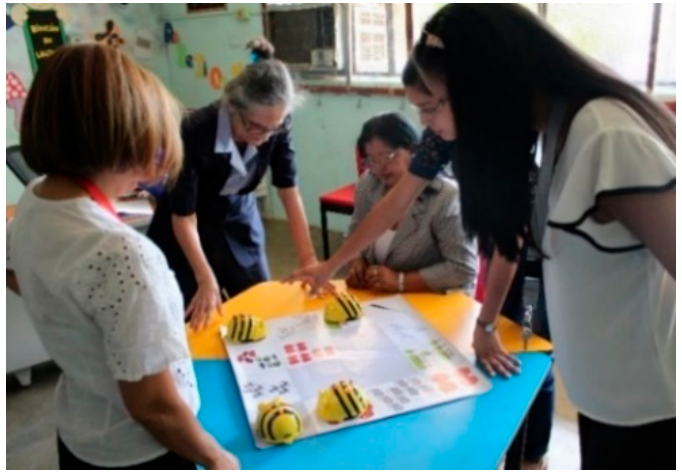
Figure 4. Practical workshop on the use of Bee Bot.